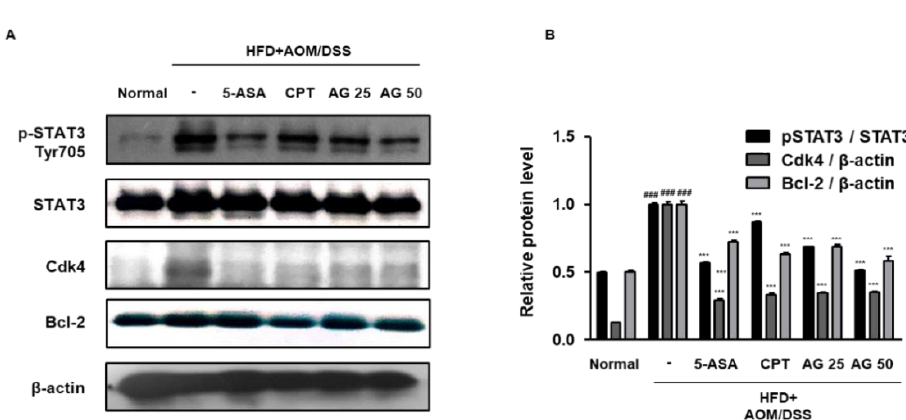
Figure 7. Effects of AG on STAT3 and STAT3 target protein expression in the HFD-propelled CAC mice model. ( A ) The protein extracts were prepared from the colon tissues and western blot analysis was performed for the detection of pSTAT3 (Tyr705), Cdk4, and Bcl-2 protein expression using specific antibodies. The relative protein level was determined by densitometric analysis normalized to the internal controls. The values are the mean ± SD ( n = 10); ### P < 0.001 vs. normal group; *** P < 0.001 vs. the HFD+AOM/DSS group; significant differences between the treated groups were determined by ANOVA and Dunnett’s post-hoc test.